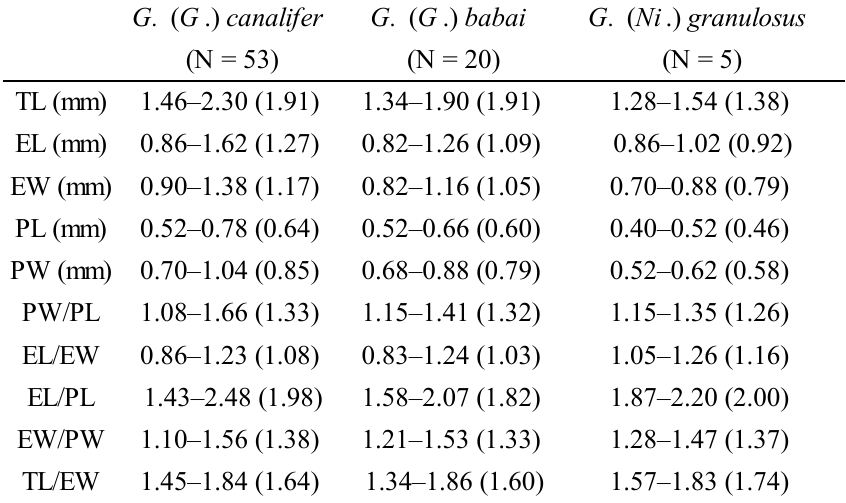
Table 1. Measurements of Georissus ( G .) spp. and G . ( Nipponogeorissus) granulosus Satô, 1972